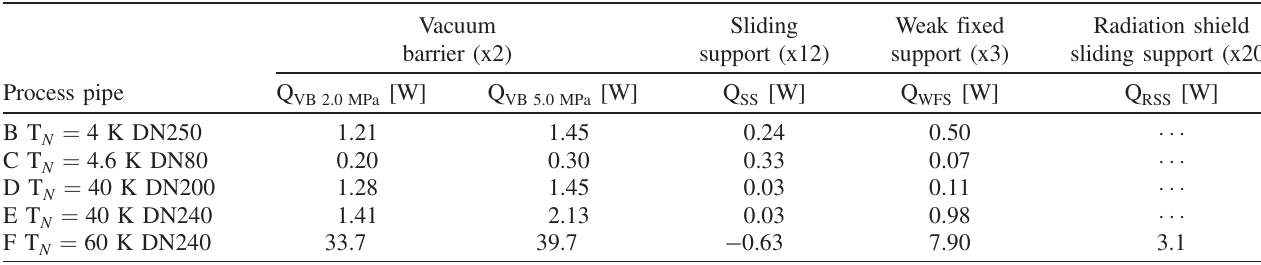
TABLE III. The determined values of heat flows for both of the analyzed cases.